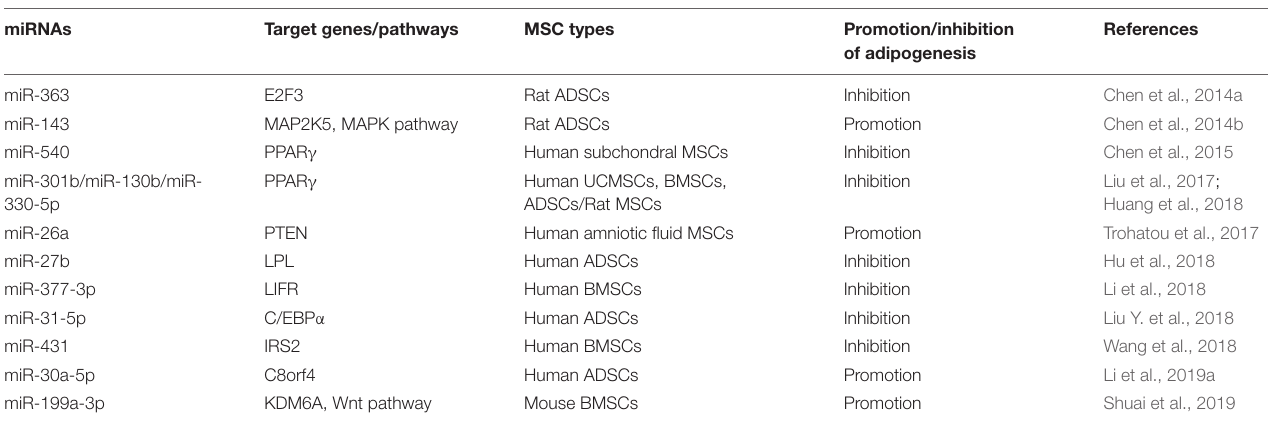
FIGURE 1 | Roles of different miRNAs in regulating adipogenesis of mesenchymal stem cells. Some miRNAs promote the adipogenesis of mesenchymal stem/stromal cells (MSCs) via silencing the expression of MAP2K5, PTEN, C80rf4, and KDM6A, while some miRNAs inhibit this process through targeting the critical factors and their activators of adipogenesis, including PPAR γ , C/EBP α , RXR γ , E2F3, and so forth. TABLE 1 | MicroRNAs involved in adipogenesis of